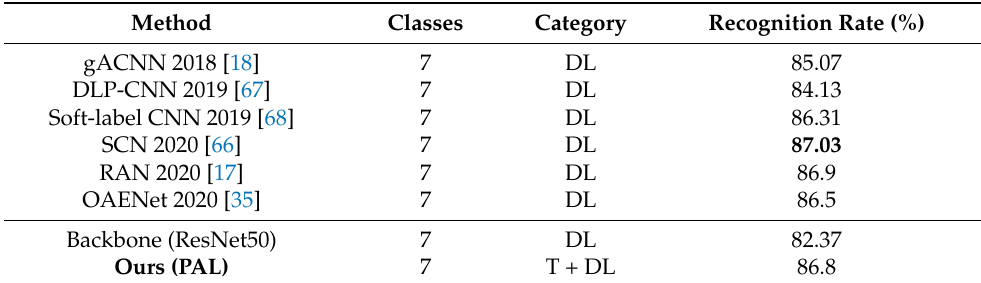
Table 4. Performance comparison with different methods on the